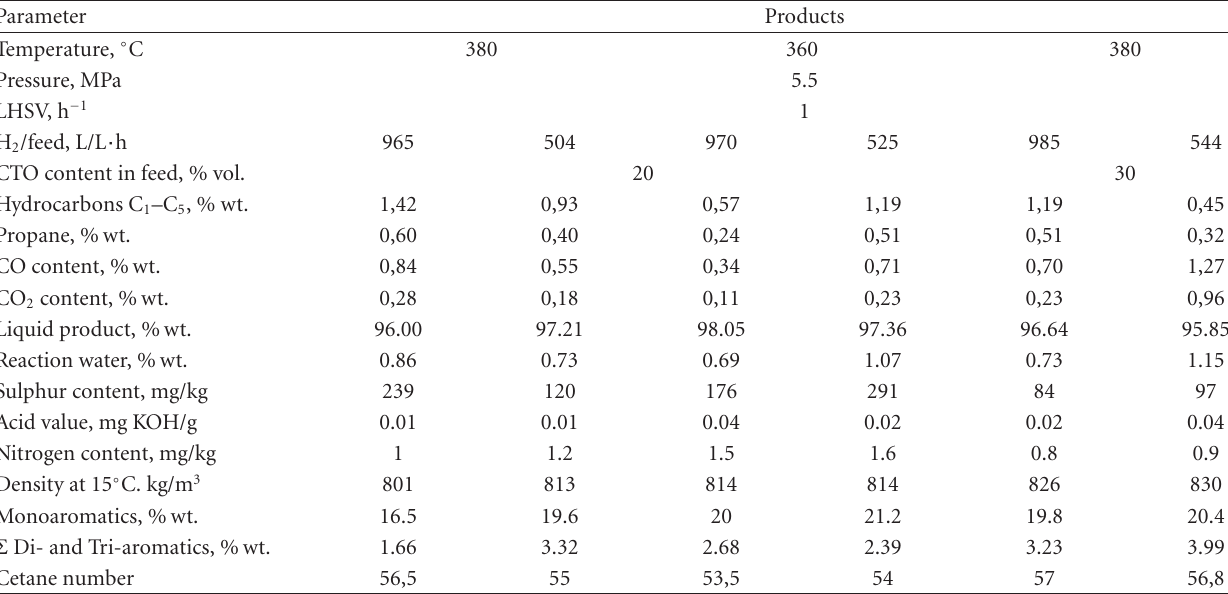
Table 4: Results of hydrorefining of the mixtures of gas oil and crude tall oil; catalyst A.